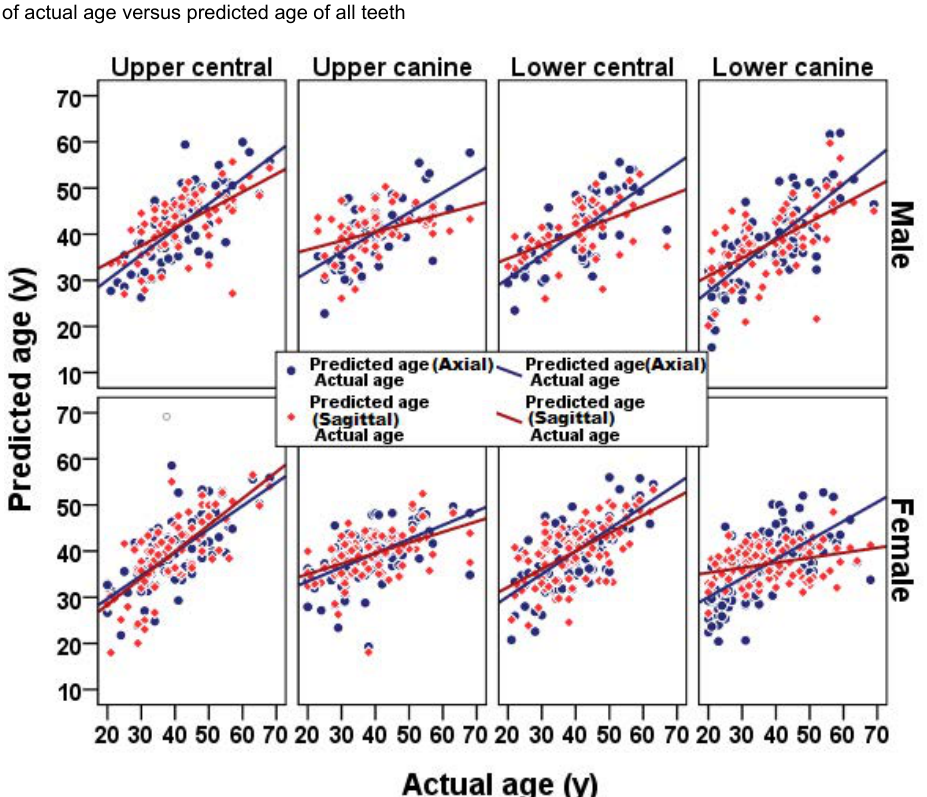
Figure 3- Plots of actual age versus predicted age of all teeth